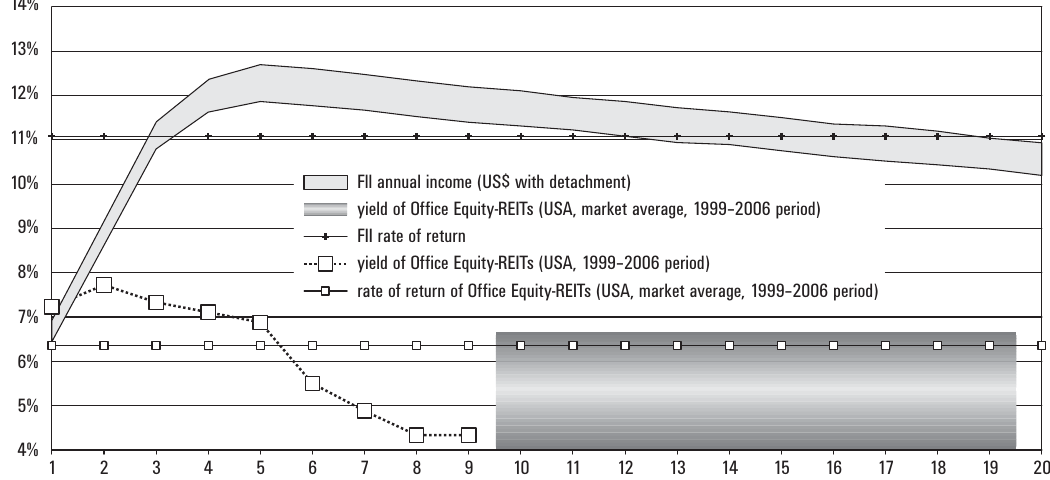
Figure 5. Yield curve and rate of return, in US dollars with exchange rate detachment and equity-REIT market